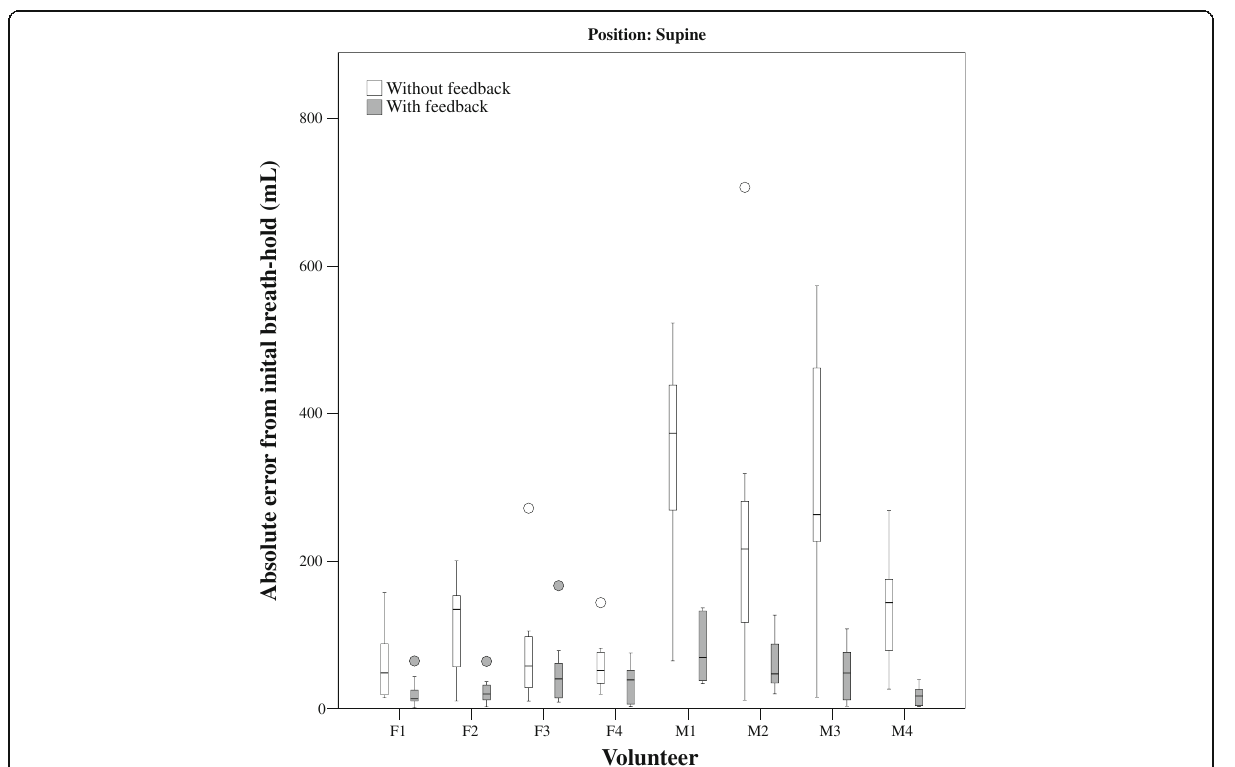
Fig. 10 Breath-hold in supine position. Box plots of the error from initial breath-hold, without and with biofeedback, grouped by volunteer, in the supine position